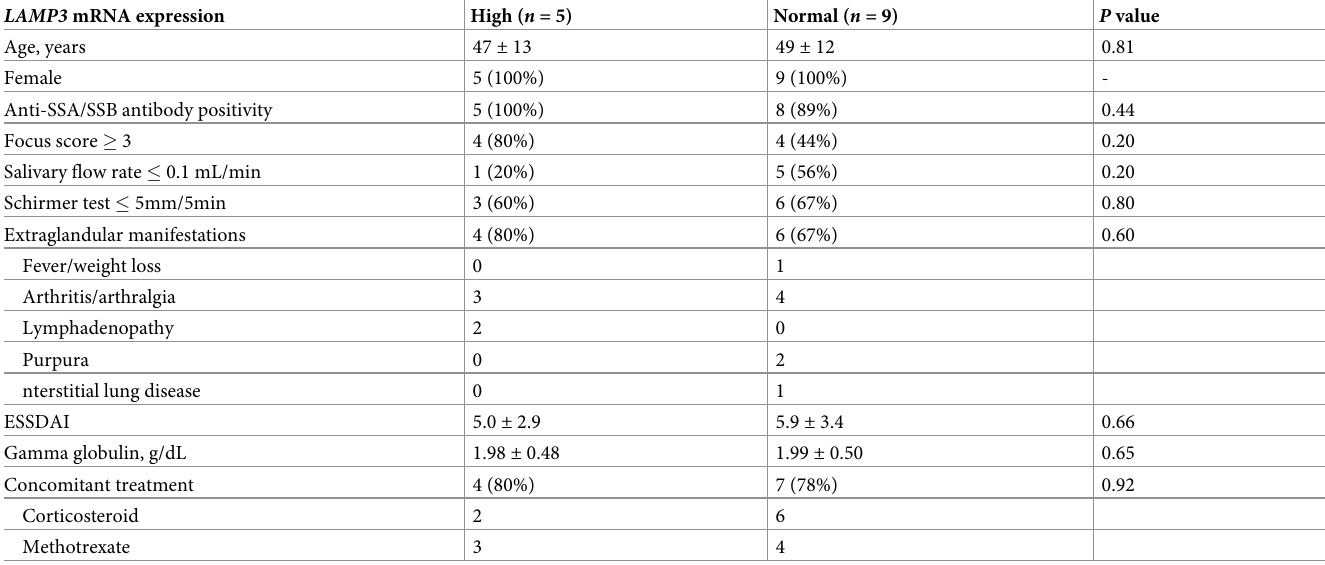
Table 1. Baseline profile of SjD patients treated with hydroxychloroquine, stratified by minor salivary gland LAMP3 mRNA